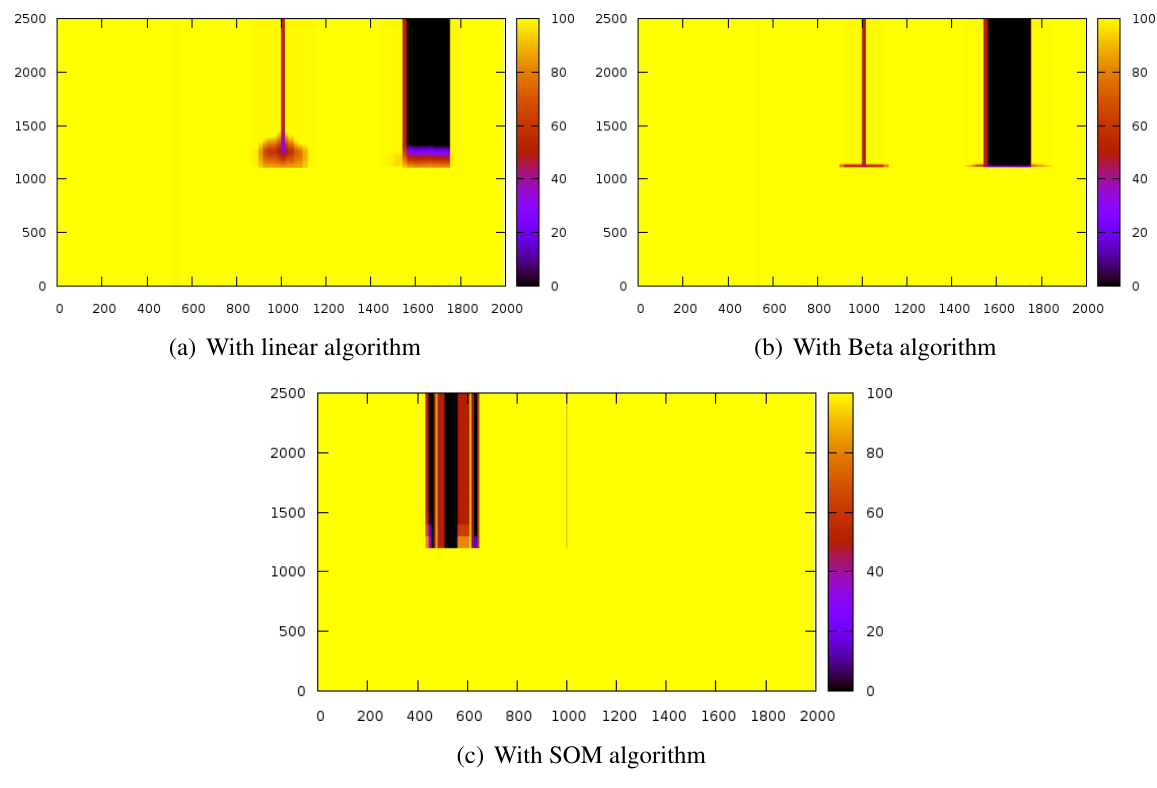
Figure 3. Reputation evolution for a sybil